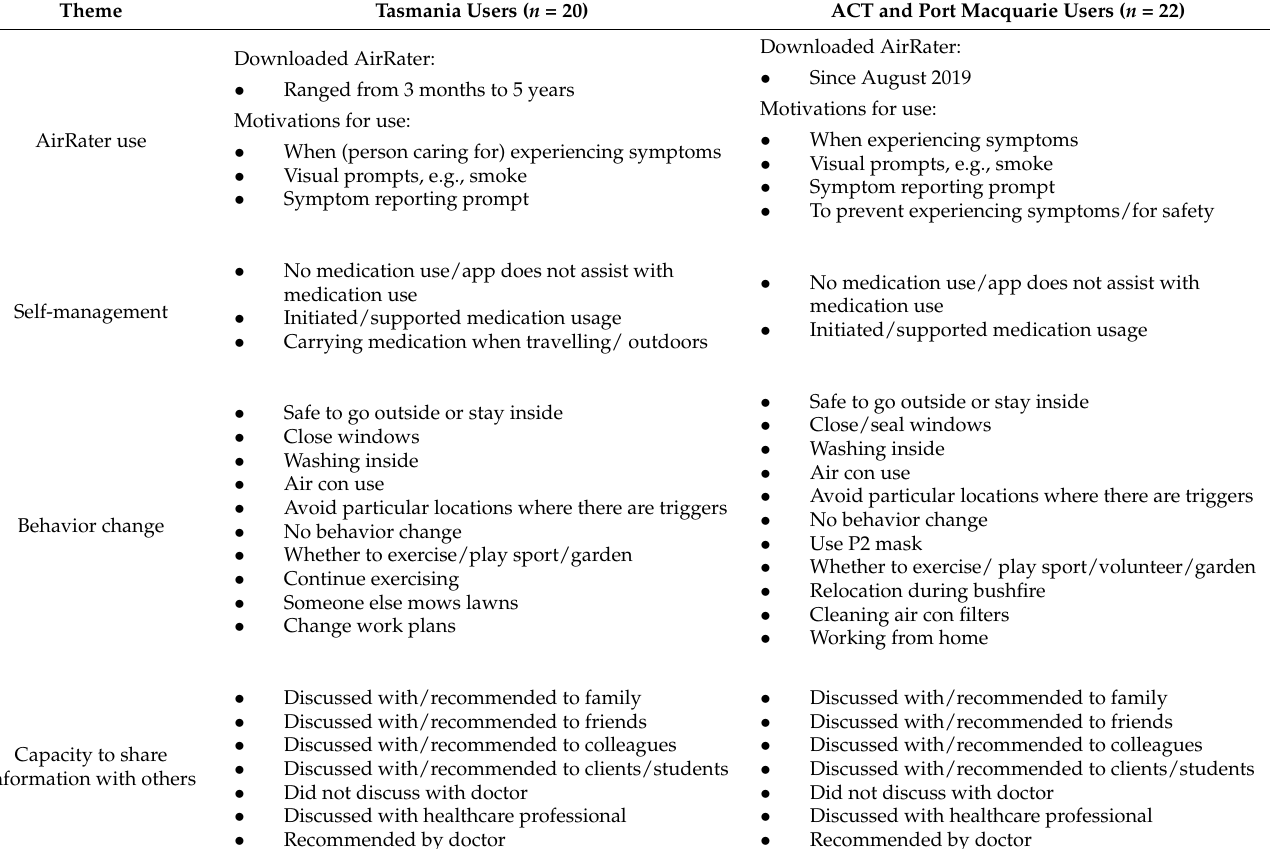
Table 1. Summary of key results from interviews with AirRater users, stratified by location.